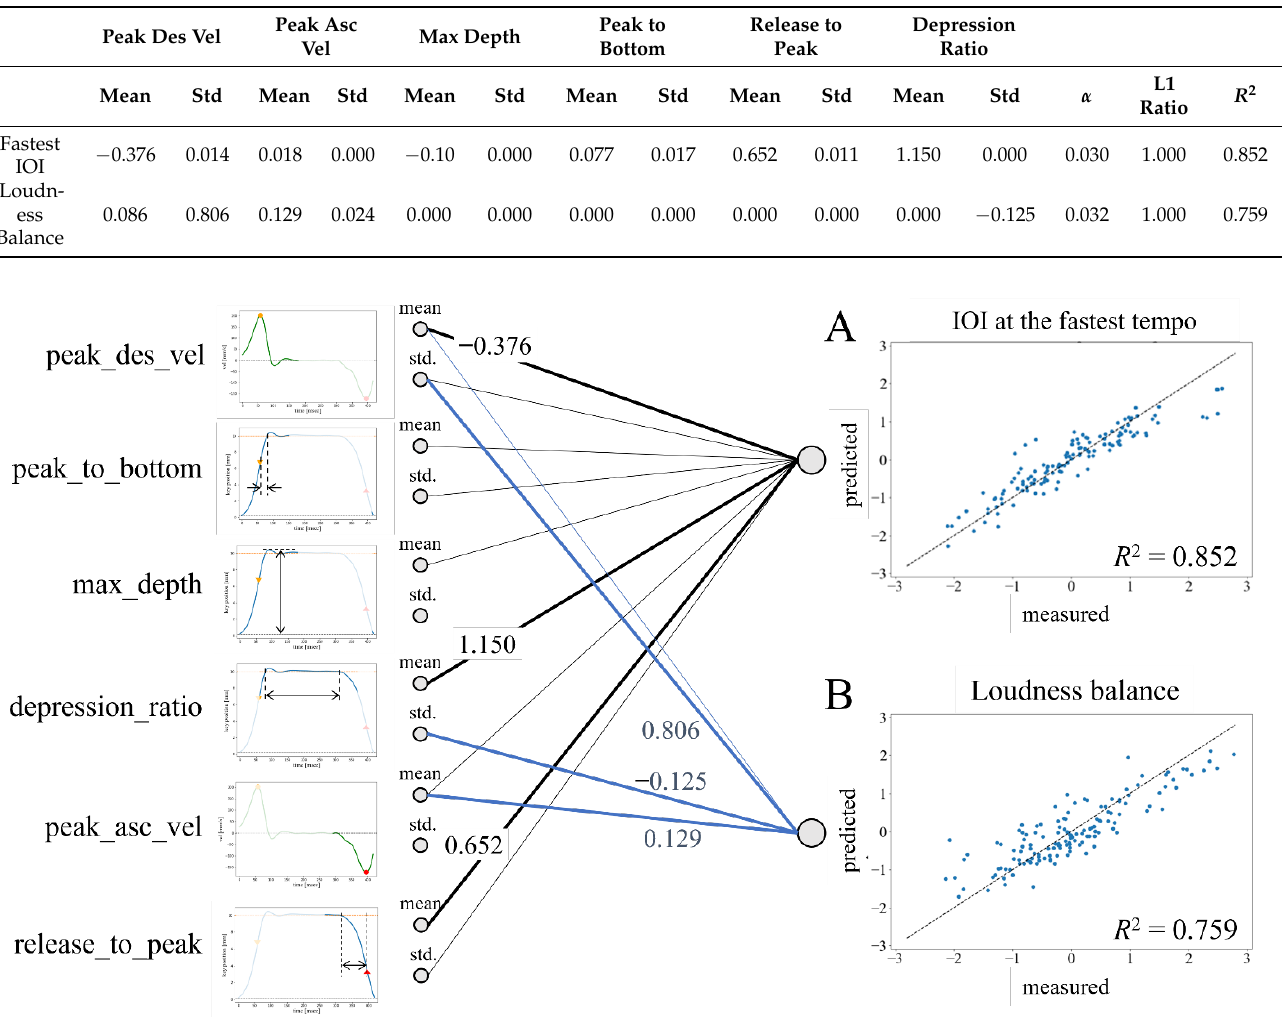
Table 1. Results of the elastic net regression.